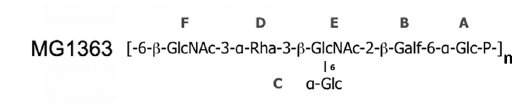
FIGURE 5 |The “pellicle” phospho-polysaccharide from L. lactis MG1363 (Chapot-Chartier etal., 2010). This phospho-polysaccharide is the receptor of lactococcal phages sk1 and